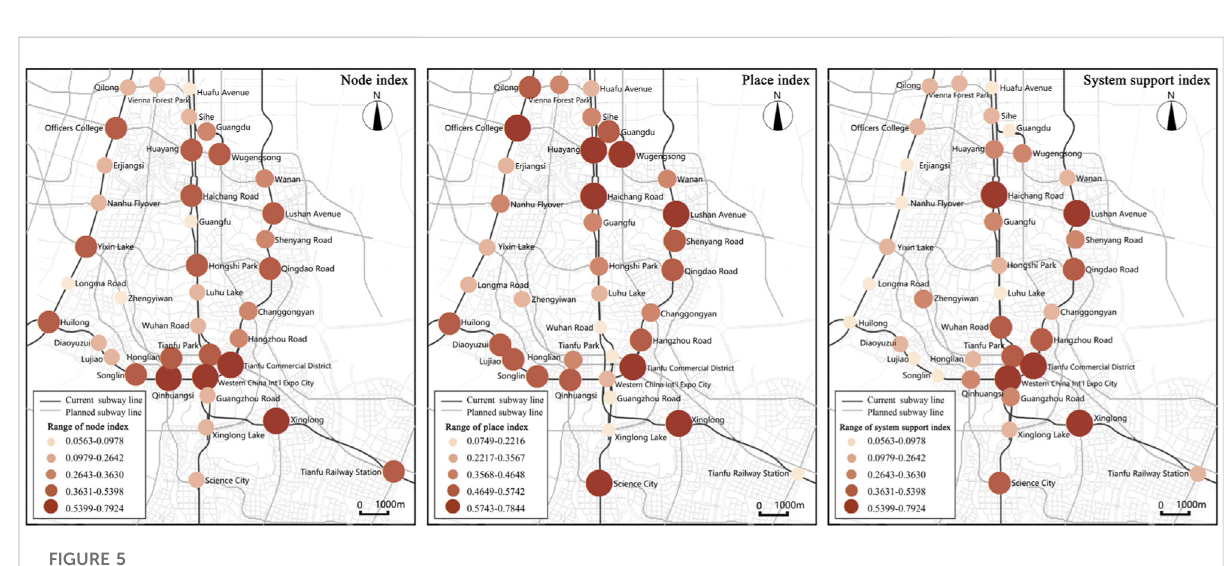
FIGURE 5 Node, place, and system support indexes of the metro stations.